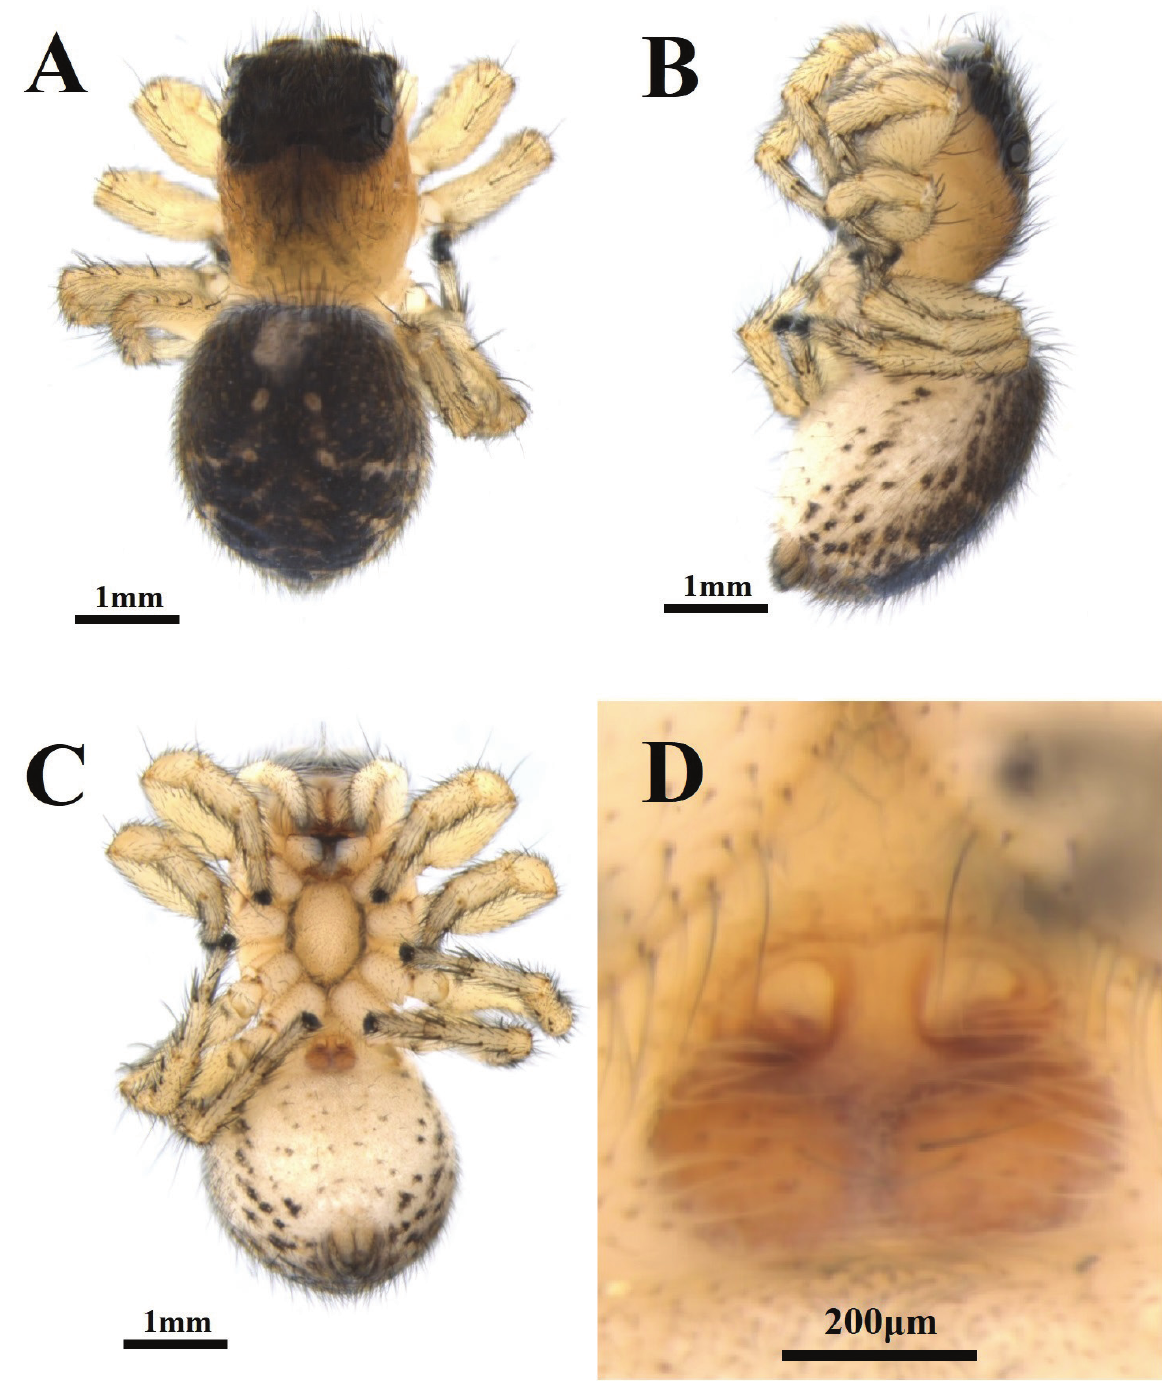
Figure 5. Preserved paratype female Maratus nemo sp. nov. (SAM NN30710) A dorsal view B lateral view C ventral view D ventral view of epigyne. Scale bars: 1mm for whole specimen, 0.2mm for